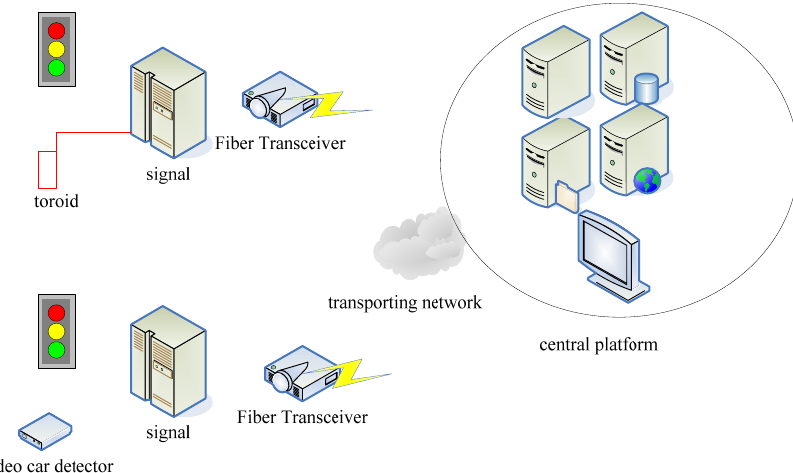
Figure 2. Intelligent monitoring and supervision system.